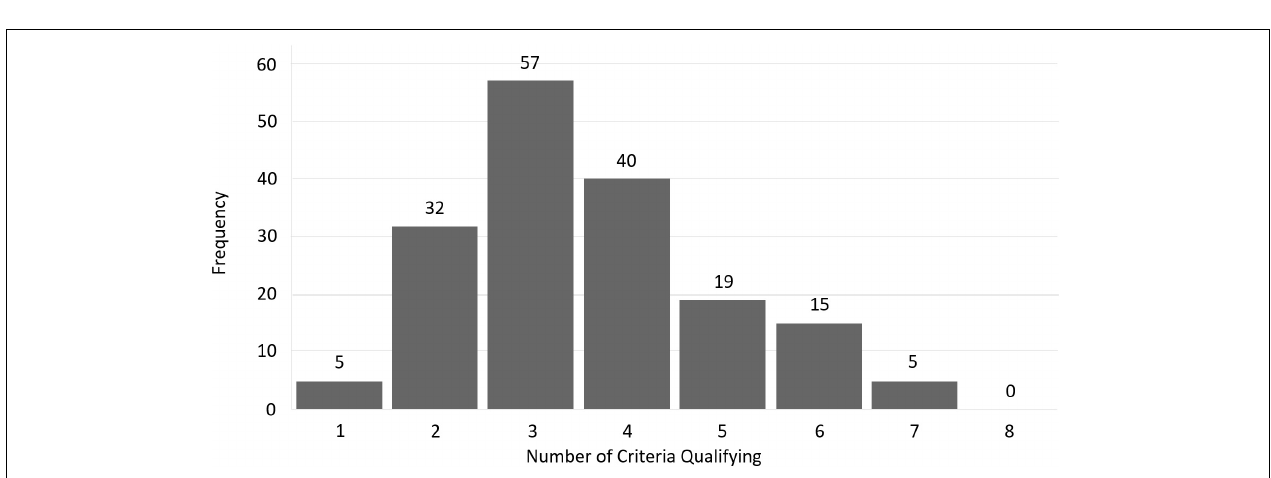
FIGURE 5 | Median values of the IMMA area size on the basis of qualifying species of cetaceans, sirenians, pinnipeds and mixed taxa (cetaceans and pinnipeds; cetaceans and sirenians). Numbers indicates the total number of IMMAs by category.